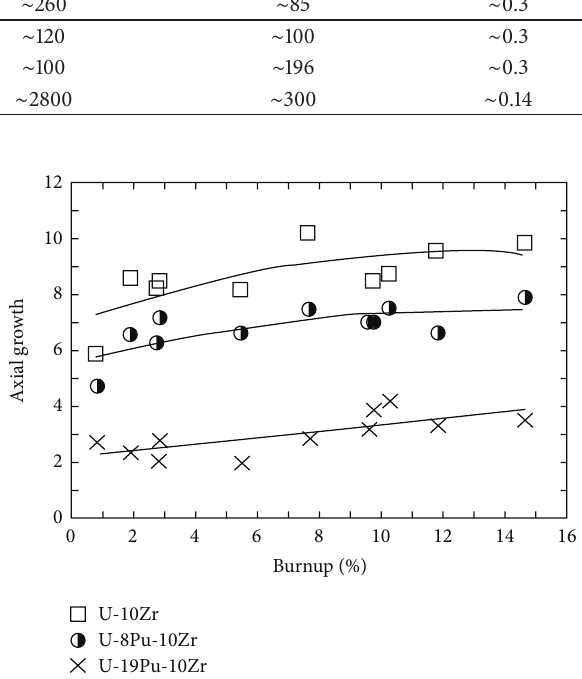
Figure 10: Axial swelling versus burnup for metallic fuel.